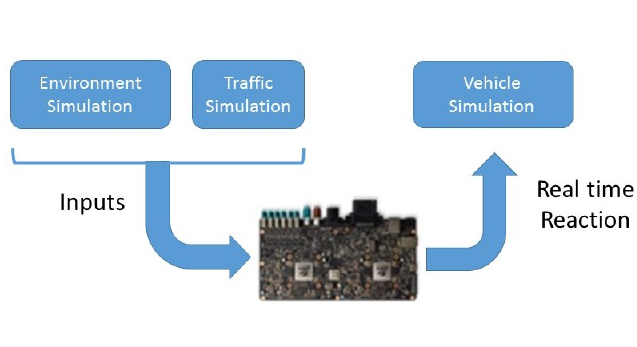
Figure 10. HIL (Hardware-in-the-loop) simulation